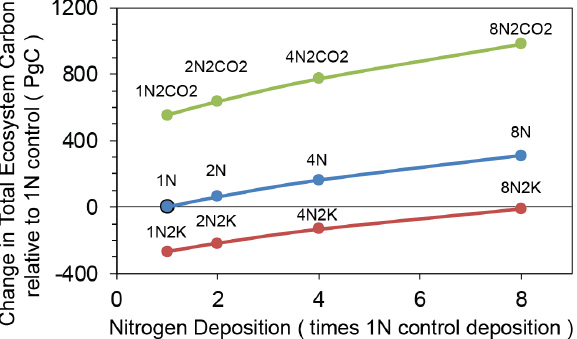
Fig. 3 Total Ecosystem Carbon (TEC) changes relative to the control simulation (1N) in the three sets of simulations. Blue line shows effect of increased N deposition. Green line shows effect of both doubled atmospheric CO 2 content and added N deposition. Brown line shows effect of both 2K warming and added N deposition. The effect of an eight-fold increase in N deposition is approximately the same magnitude but opposite in sign to that of a 2K warming.